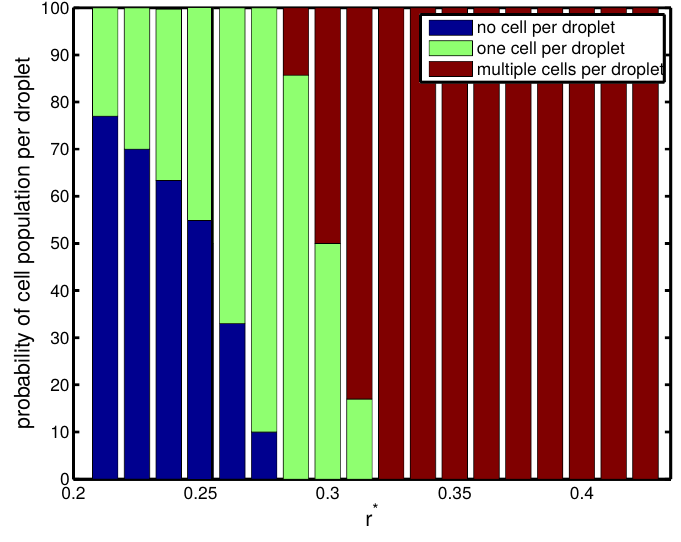
Figure 4. Probability of cell population per droplet (%) for configurations with different non-dimensional orifice radii at Ca i = Ca o = 10 − 3 . Other geometrical parameters are kept fixed ( l ∗ = 0.5 and d ∗ =